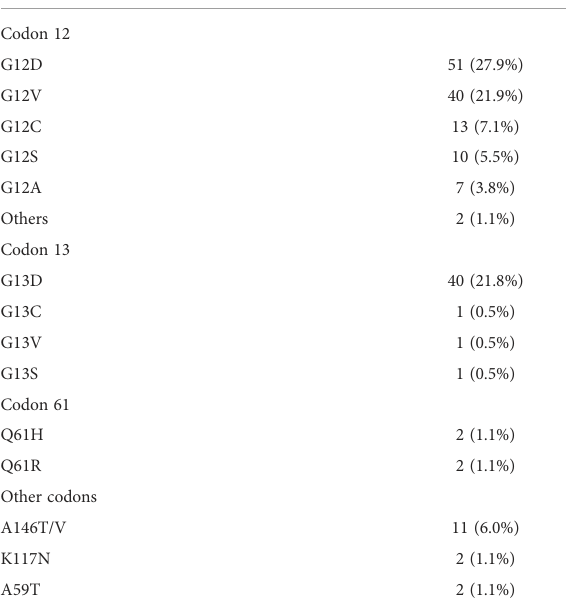
TABLE 2 KRAS mutations (patients,